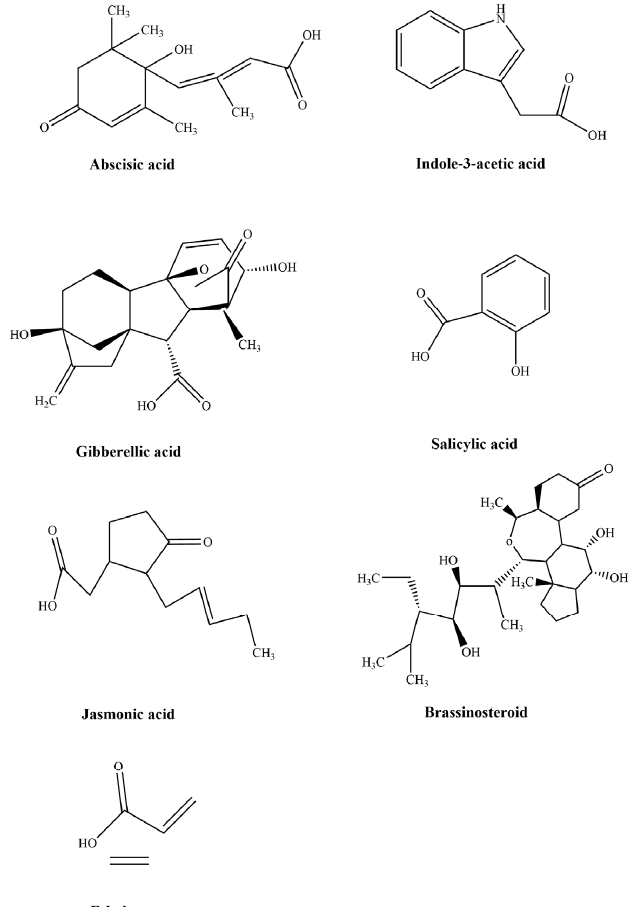
Figure 4. The molecular structures of all the mentioned phytohormones, including abscisic acid, Indole-3-acetic acid, gibberellic acid, salicylic acid, jasmonic acid, brassinosteroid, and ethylene. The figure was drawn by ChemDraw 2022 (CambridgeSoft, Cambridge, MA, USA).